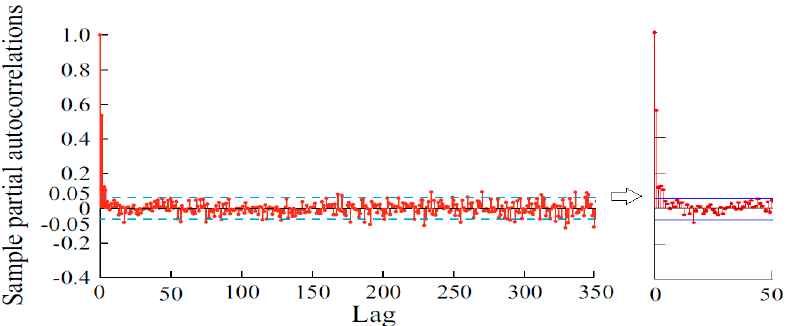
Figure 4. Partial autocorrelation function (PACF) plot for RTG crane demand time series for 350 ‐ time lags and the cut off after lag number 4.